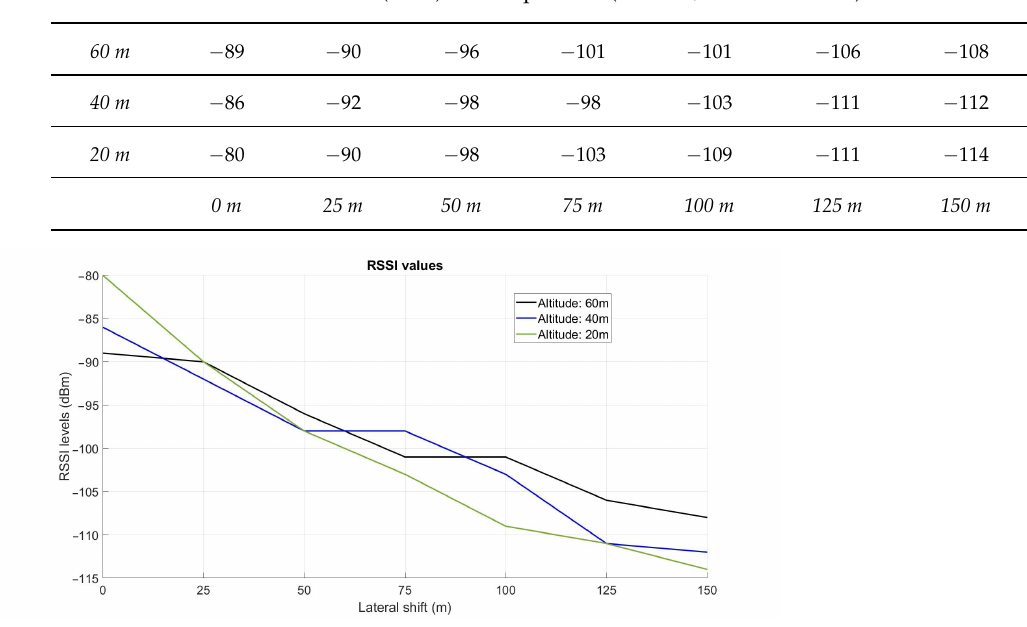
Figure 16. Evolution of the RSSI levels with respect to the lateral shift of the